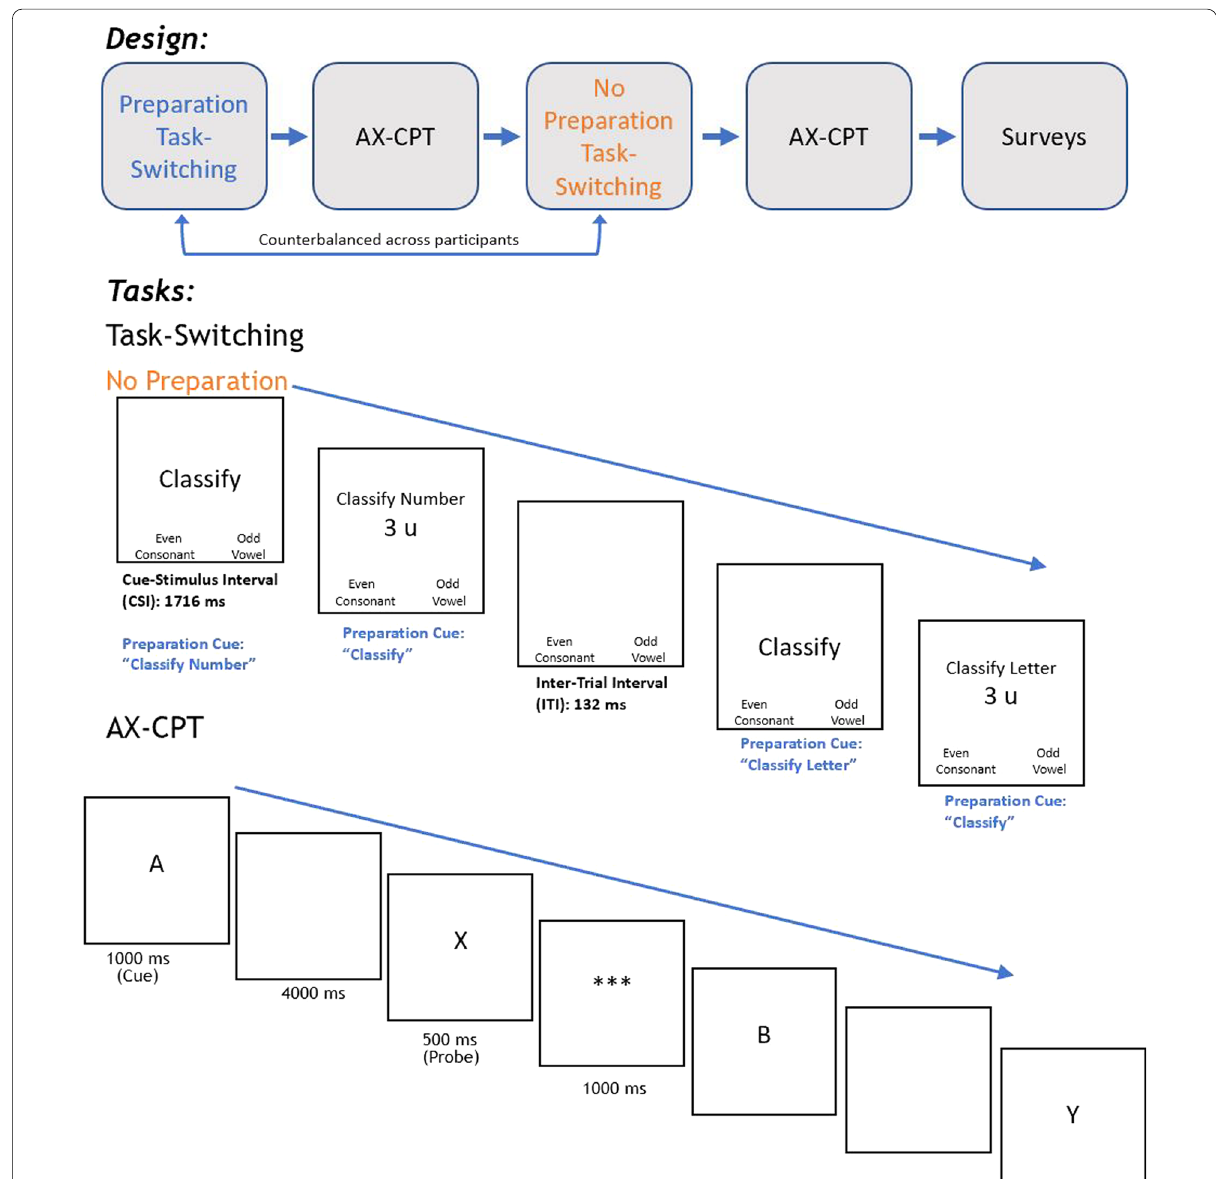
Fig. 2 Task design for Registered Experiment. Cues for the preparation condition are indicated in blue text. Inter-trial interval denotes time period after participant makes a response and before the cue for the next trial is presented (i.e., response-cue